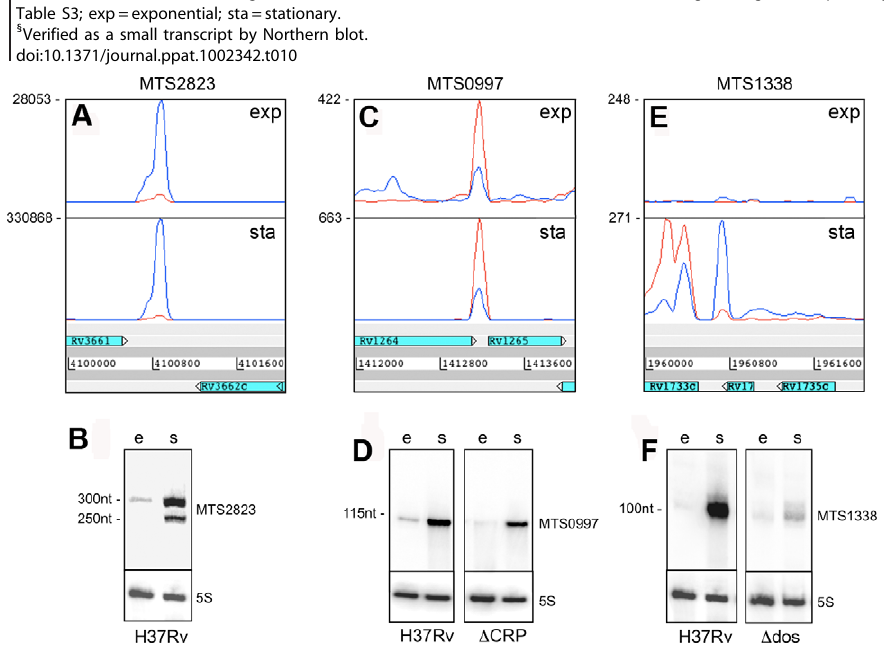
Figure 7. Intergenic sRNAs. Transcription profiles and Northern blots showing the expression of M. tuberculosis sRNAs in exponential and stationary phase.A and B. MTS2823 is the most abundant sRNA during exponential growth (‘‘e’’), with a further increase seen in stationary phase (‘‘s’’). C and D. MTS0997 is readily detectable by RNA-seq and by Northern blot during exponential growth, with a significant increase in stationary phase. Expression of MTS0997 was reduced in both growth phases in a strain of M. tuberculosis lacking the cAMP receptor protein (CRP). E and F. MTS1338 is barely detectable during exponential growth, but is strongly induced in stationary phase. The sRNA transcript partially overlaps Rv1734c, which is oriented in the reverse direction to MTS1338 and annotated as encoding a hypothetical protein. Deletion of the DosR two-component regulator markedly reduces, but does not entirely eliminate stationary phase expression of MTS1338.